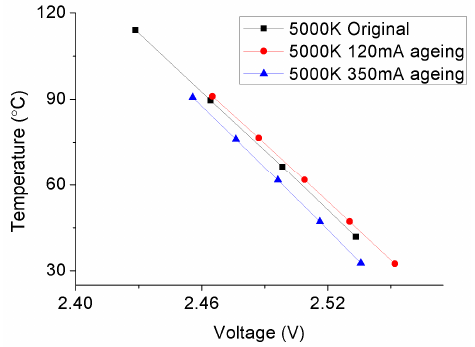
Figure 7. Temperature-voltage curves of the 5000 °K samples before and after SSADT with 2046 h.